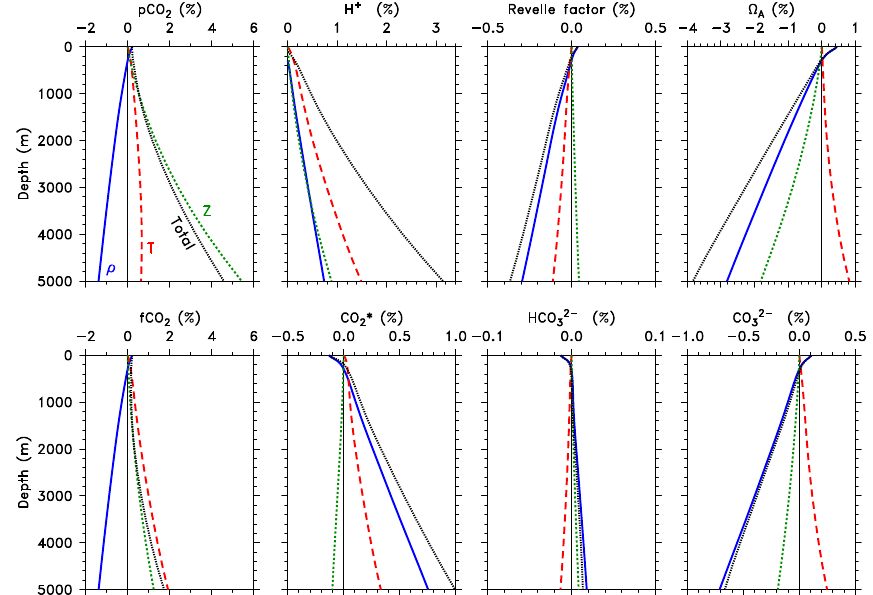
Figure 6. Relative changes in global-mean profiles that result from avoiding each of the three ocean-model approximations: (1) that density is constant (blue ρ ), (2) that potential temperature is equivalent to in situ temperature (red T ), and (3) that depth (m) is equivalent to pressure (dbar) (green Z ). Also shown is the sum of all three effects (black). Associated errors are equal but opposite in sign to the changes